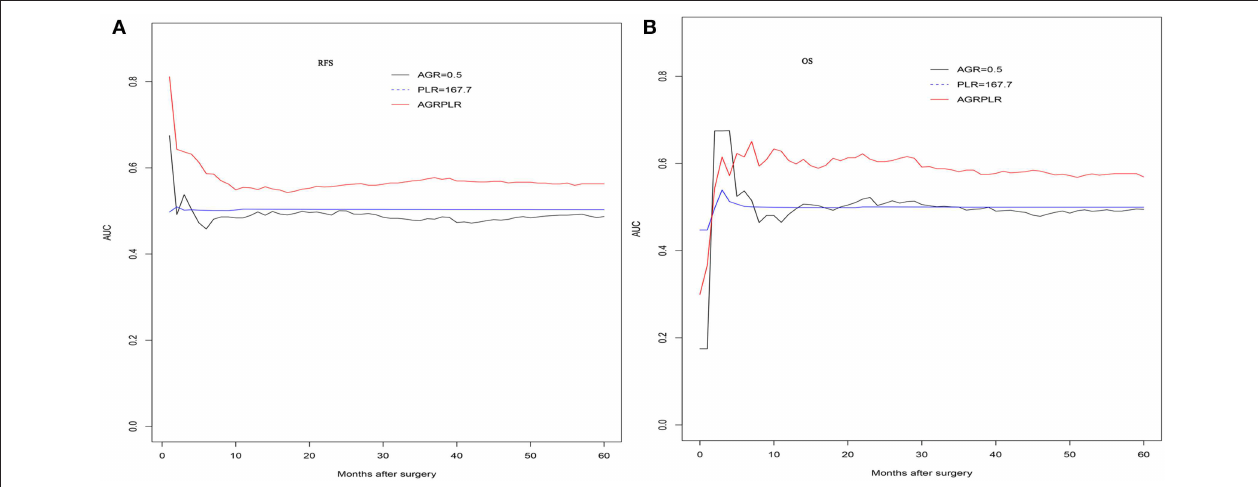
FIGURE 5 | The time-dependent ROC curves of AGR and AGR-PLR in RFS and OS prediction. Compared with AGR, the AUROC of AGR-PLR was the higher for RFS (A) and OS (B)